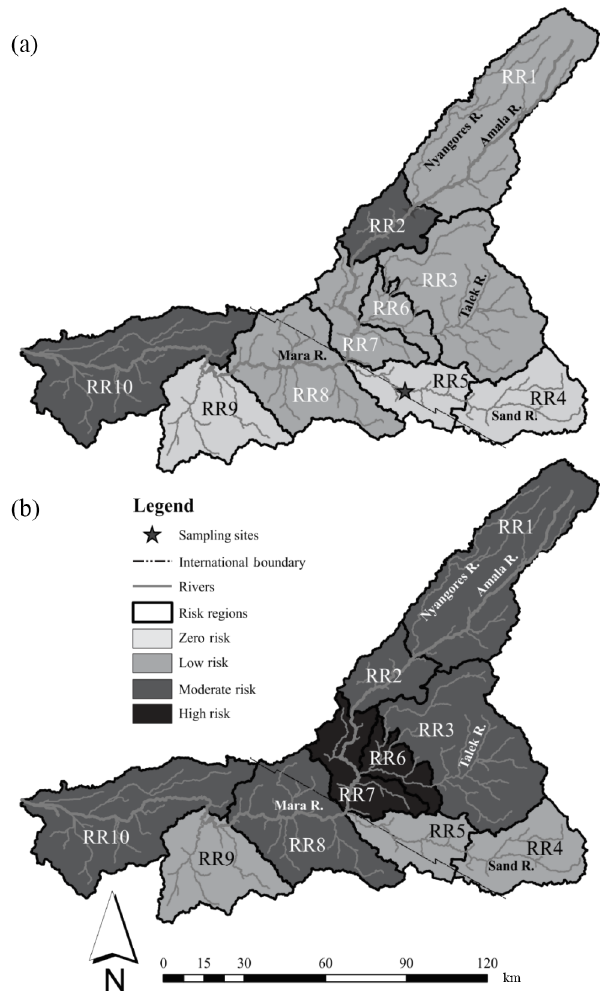
Figure 11. Relative spatial risk of the multiple sources and stressors associated with current (a) and planned (b) water resource use to risk regions (RRs) selected for the Mara River basin case